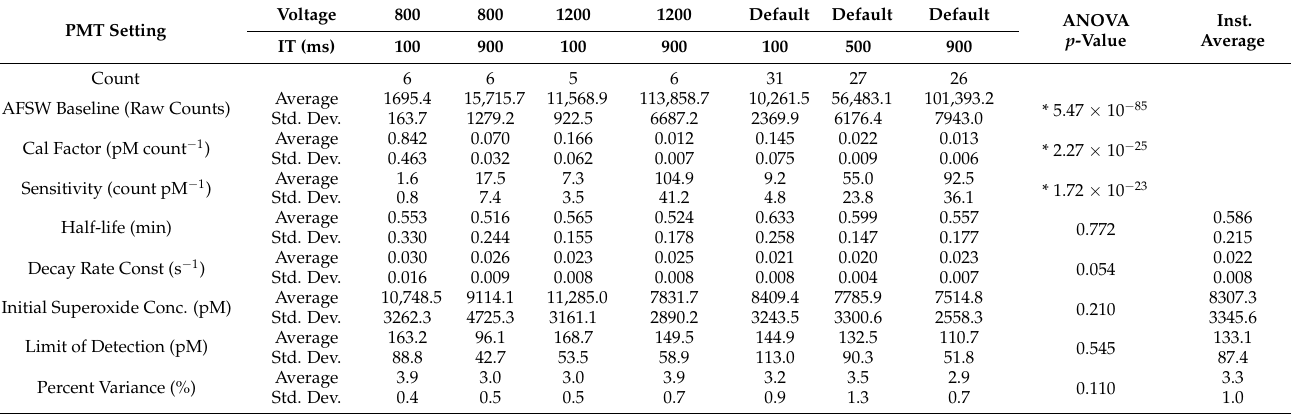
Table 2. Summary of DISCO II calibrations within the laboratory at different voltages (800, 1200, and default) and integration times (IT: 100, 500, 900 ms). The average and standard deviation of results are displayed for calibrations conducted within aged, filtered seawater (AFSW). Displayed are the baseline counts prior to superoxide spike (raw counts), the calibration factor (pM count − 1 ), the sensitivity (count pM − 1 ), the half-life of superoxide during the calibration (min), the decay rate constant (s − 1 ), the initial concentration of superoxide (pM), the limit of detection (pM), and the percent variance (%). The ANOVA p -value is indicated for each measurement across different PMT settings, with an “*” indicating statistical significance ( p -value < 0.050). For those measurements that were not statistically different across PMT settings, the instrument (inst.) average and standard deviation across all settings are